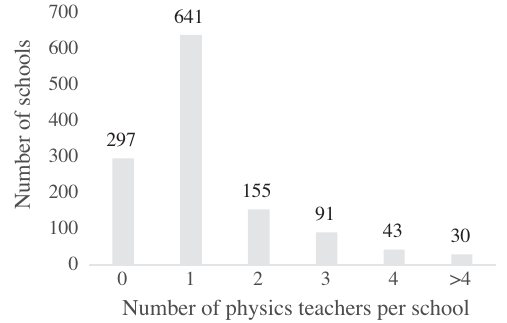
FIG. 3. Frequency of schools with isolated physics teachers in comparison to schools with nonisolated